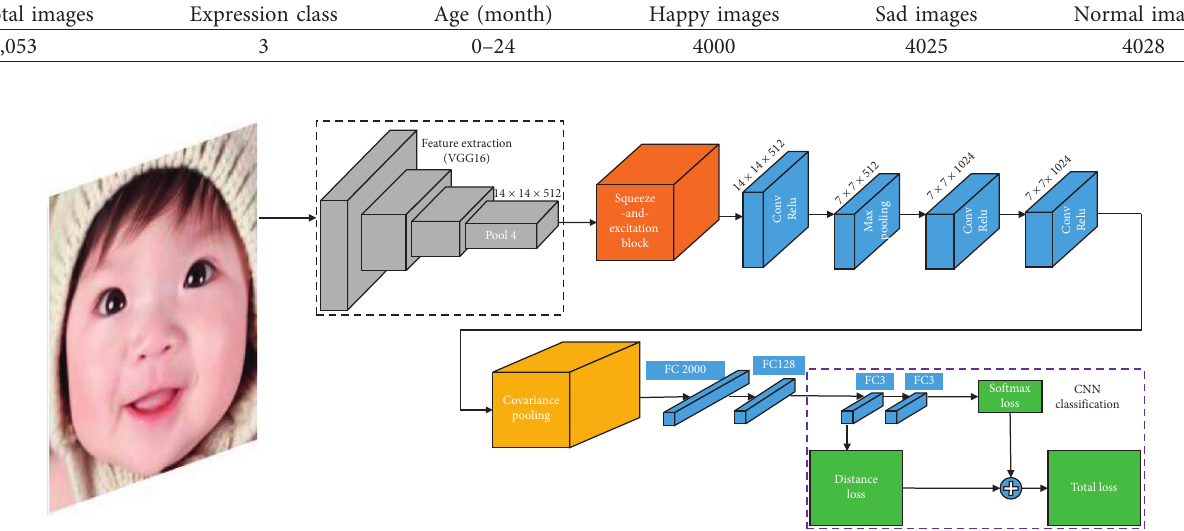
Figure 3: The overall architecture of the proposed deep learning approach